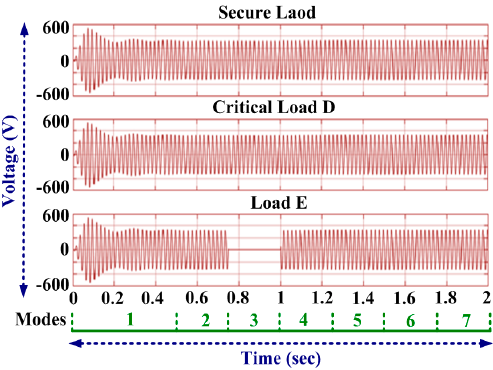
Figure 11. Output voltage of (top to bottom: secure load B, critical load D, and load E). Energies 2019 , 12 , x FOR PEER REVIEW